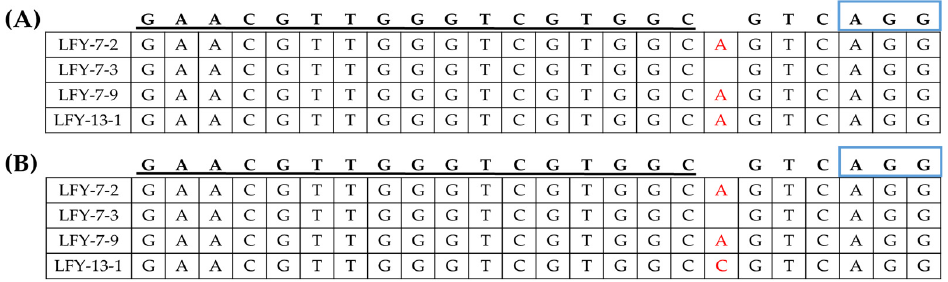
LFY -edited lines. ( A ) Mutagenesis of CT001_A02071870 at the genomic DNA level in the E 1 LFY -edited lines. ( B ) Mutagenesis of CT001_A06214910 at the genomic DNA level in the E 1 LFY -edited lines. sgRNA sequence is underlined in black and blue rectangles indicating PAM sequence. Insertion mutations are indicated using red